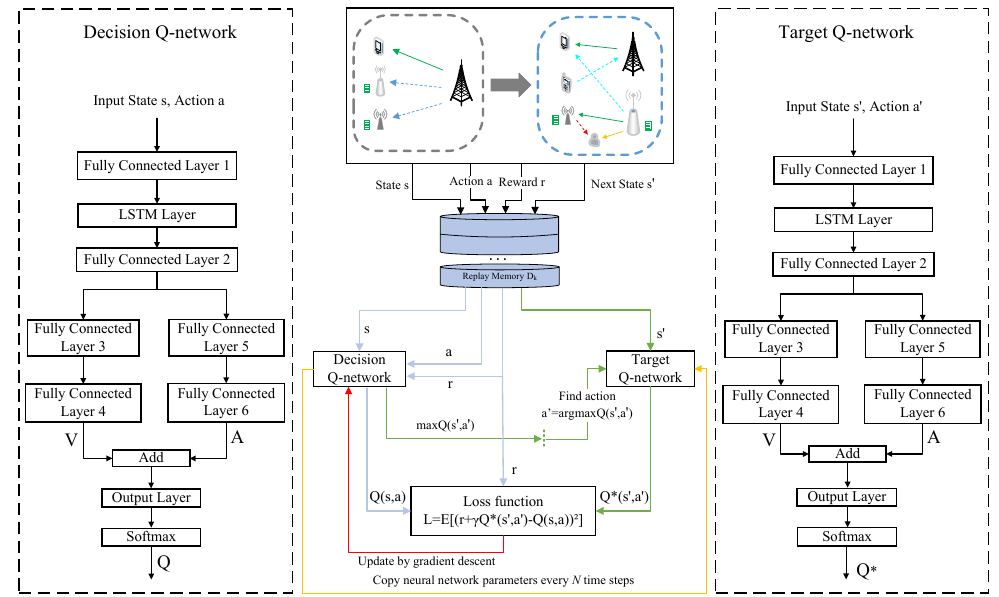
Figure 4. LSTM-D3QN network